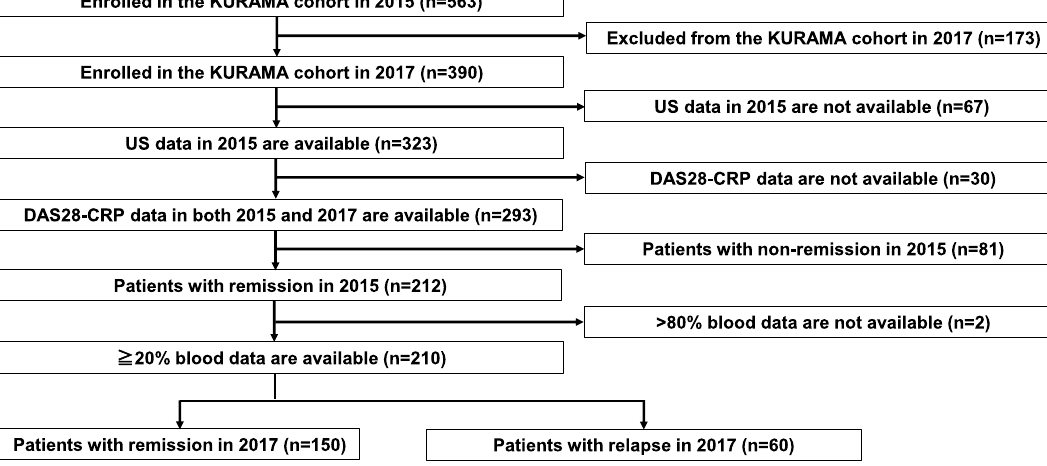
Figure 1. Flow chart depicting patient selection. From 563 RA patients enrolled in the KURAMA cohort in 2015, 390 patients with available follow-up data in 2017 were selected. Next, 323 patients whose US data were available in 2015 were selected. Of the 323 patients, DAS28-CRP data in 2015 and 2017 were available in 293 patients and 81 patients with non-remission (DAS28-CRP ≥ 2.3) in 2015 were excluded. Two of the 212 patients in remission (DAS28-CRP < 2.3) in 2015 lacking the most blood test data (> 80%) were excluded. Finally, the remaining 210 patients were divided into Group 1 (patients with remission in 2017, n = 150) and Group 2 (patients with relapse in 2017, n = 60). KURAMA Kyoto University Rheumatoid Arthritis Management Alliance, US ultrasound, DAS28 disease activity score on 28 joints, CRP C-reactive